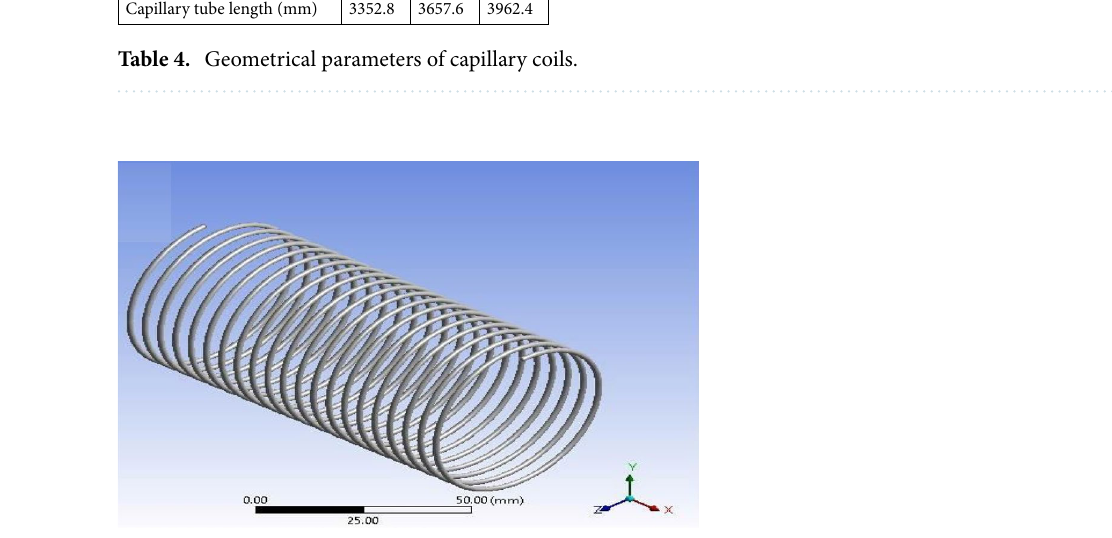
Figure 2. ANSYS FLUENT model of Tube-1 (3352.8